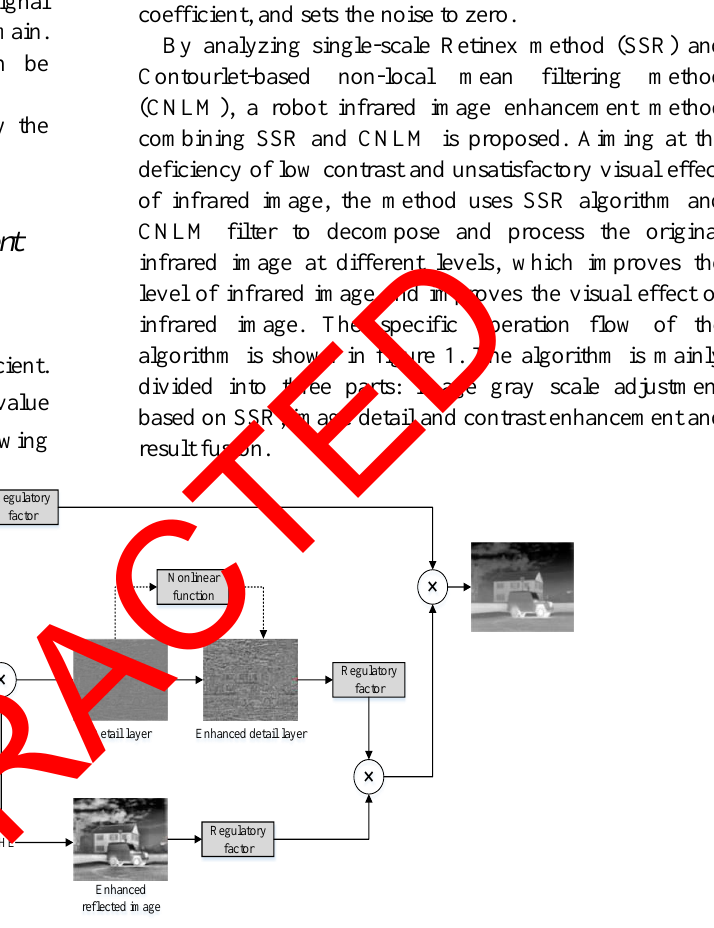
Figure 1. Flow chart of proposed